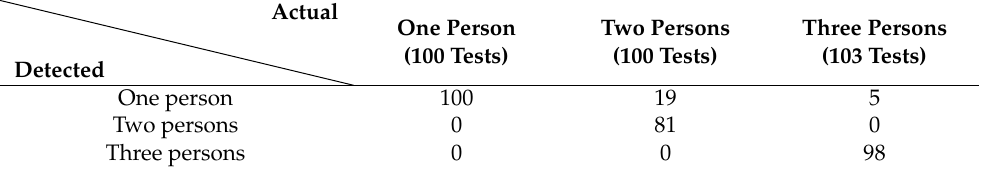
Table 1. Test results of the numbers of persons in the case of a large laboratory.